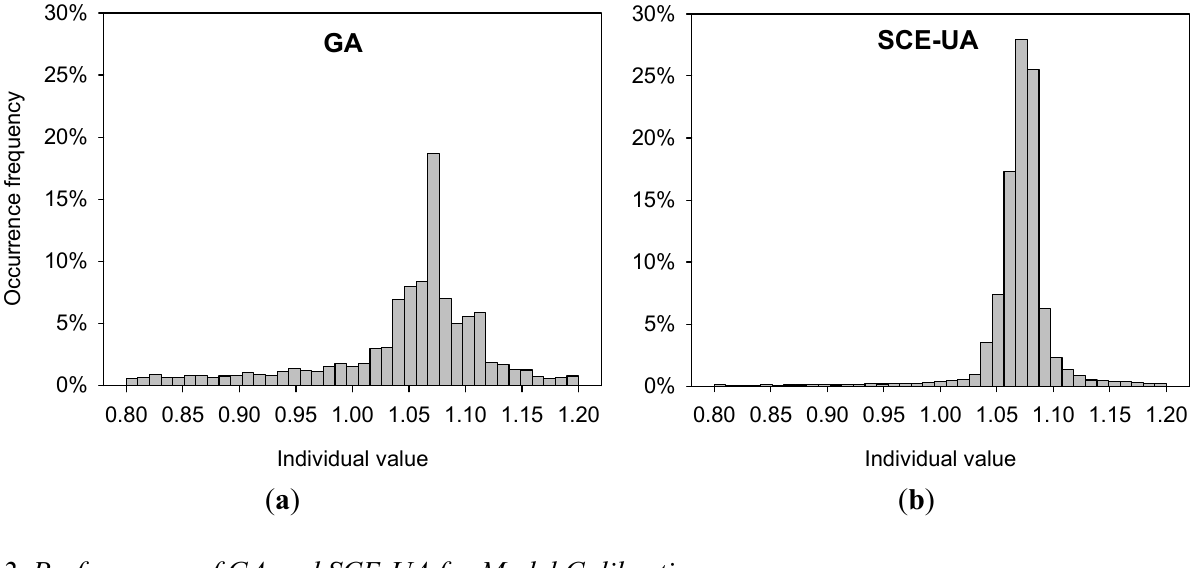
Figure 9. Histograms for generated individuals by GA and SCE-UA. Number of model runs were 20,000 for SCE-UA and 20,300 (100 individual/generation and 200 generations) for GA. ( a ) Histogram for GA; ( b ) Histogram for SCE-UA.